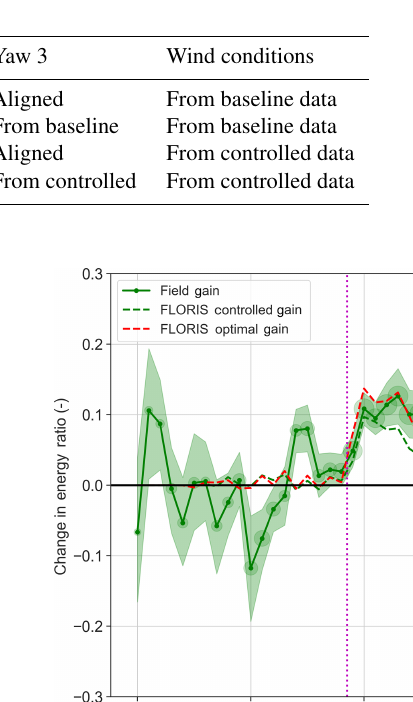
Table 1. FLORIS model definitions for comparison. The columns yaw 4 and yaw 3 determine what sets the yaw angle for each turbine (aligned is always 0 ◦ ), with optimal being the true optimal; “from baseline” means applying the observed yaw angles from the baseline data of the field campaign. Wind conditions are similarly defined.